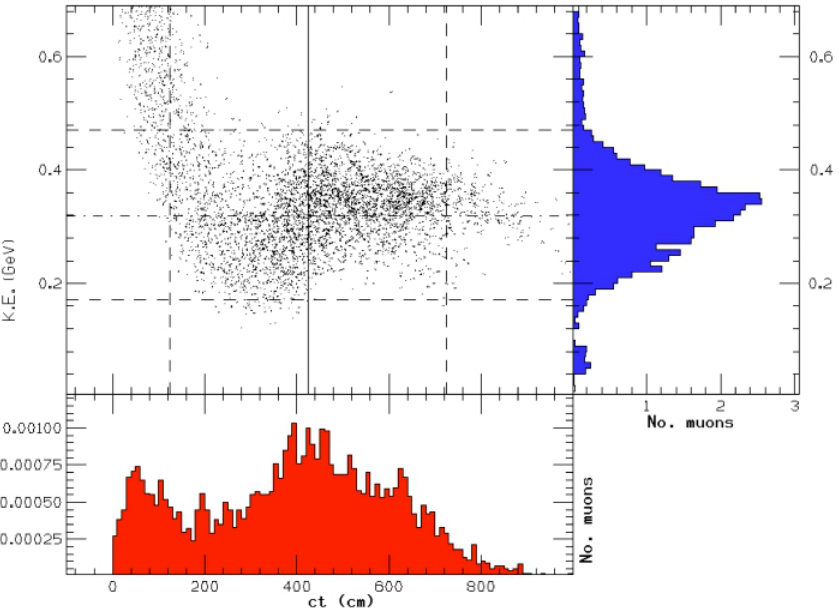
FIG. 19. (Color) Longitudinal phase space at the end of decay channel with projections onto time and energy axes per incident proton. The four dashed lines delineate the region deemed acceptable for the cooling channel.